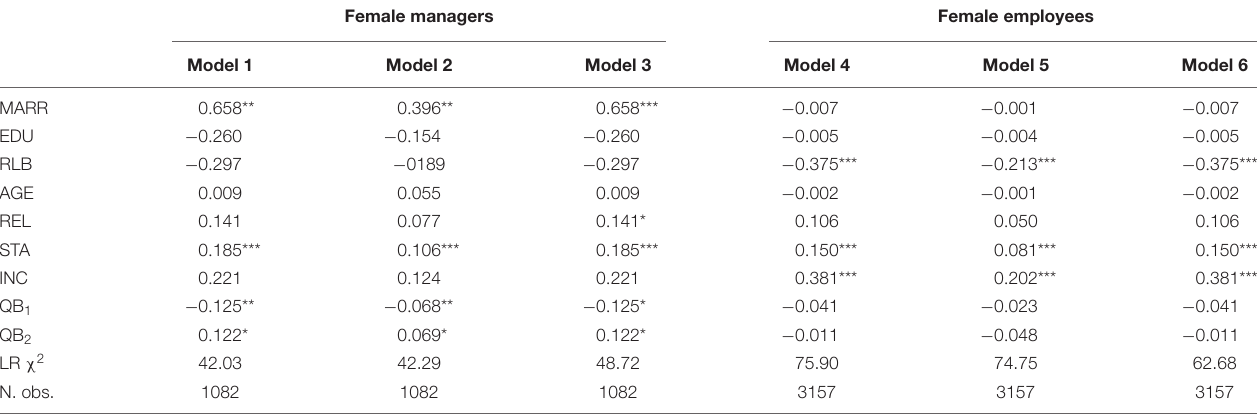
TABLE 6 | Determinants of subjective happiness (managers and employees).